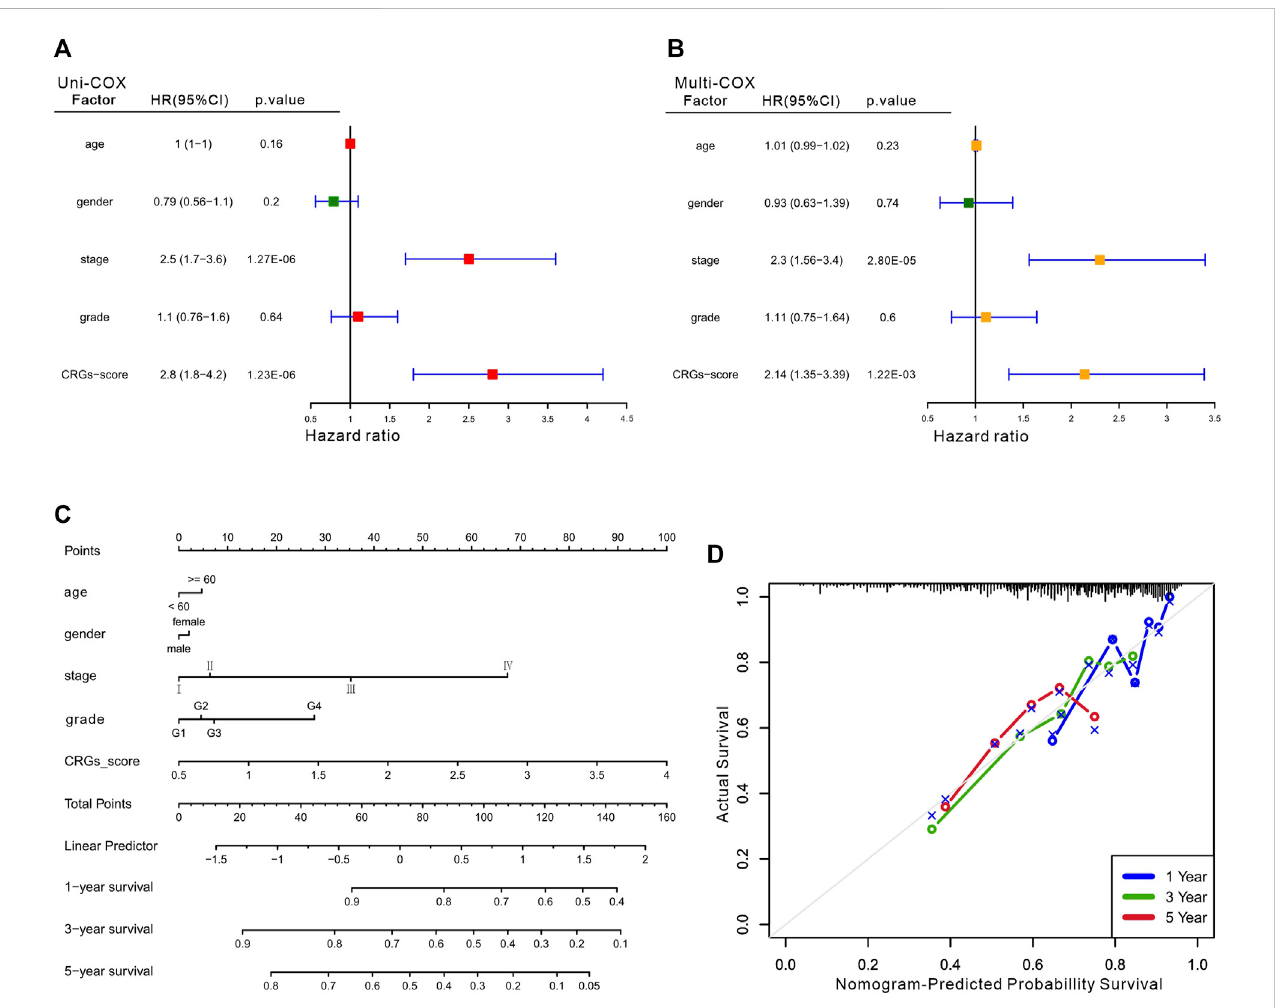
FIGURE 5 The clinical features of the CRGs-score model. The forest plot for univariate Cox (A) and multivariate Cox regression (B) considering clinical indicators and CRGs-score in HCC cohort. (C) Nomogram incorporating age, gender, stage, grade and CRGs-score was a predictor of 1-, 3-, and 5-year overall survival probabilities in HCC patients. (D) Calibration curves of 1-, 3-, and 5-year of survival